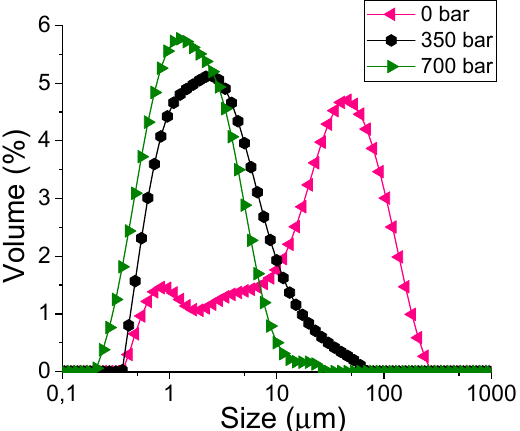
Figure 5. Droplet size distributions for thyme emulsions containing 0.4 wt % of rhamsan gum as a function of the homogenization pressure applied in the microfluidizer. Fluids 2019 , 4 , x